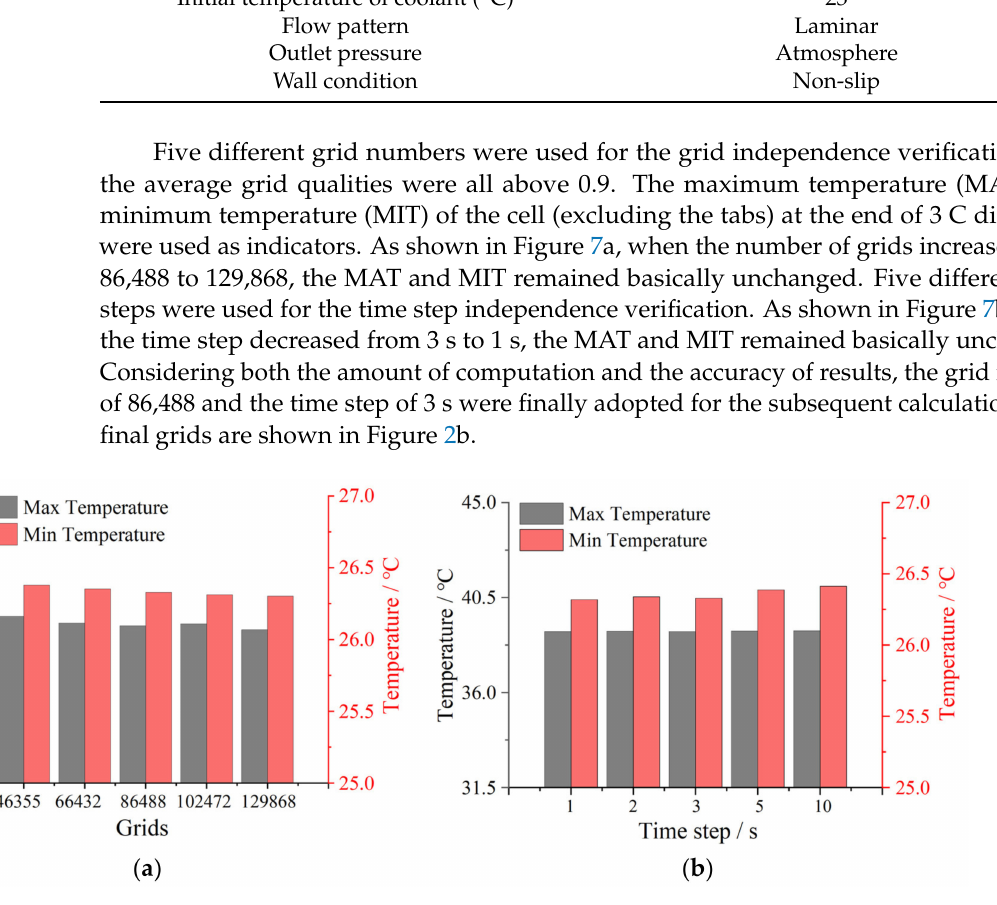
Figure 7. ( a ) Grid independence verification; ( b ) time step independence